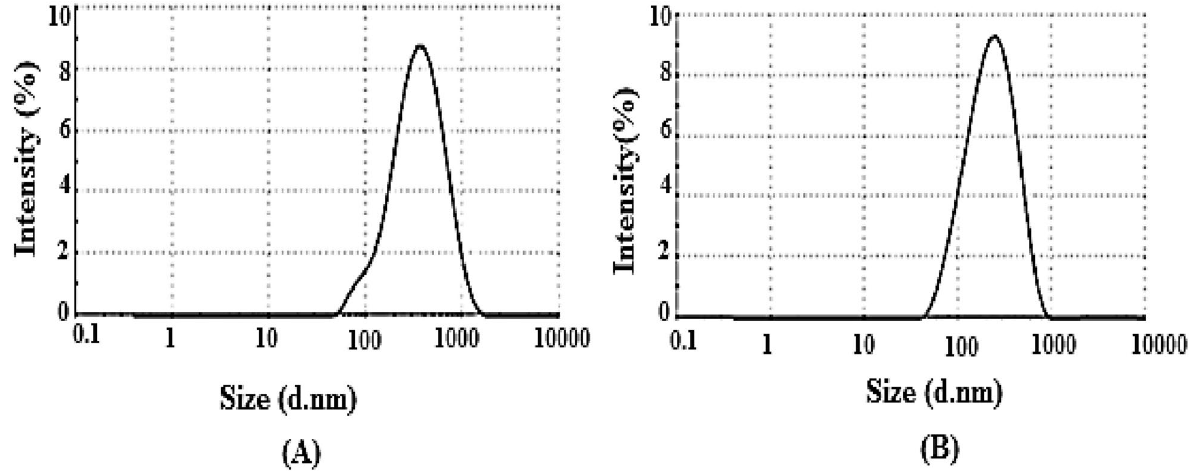
Figure 5. Particle size distributions of silica nanofluids by intensity ( A ) the effects of divalent cations (Ca 2+ and Mg 2+ ). ( B ) LSSW without divalent cations (Ca 2+ and Mg 2+